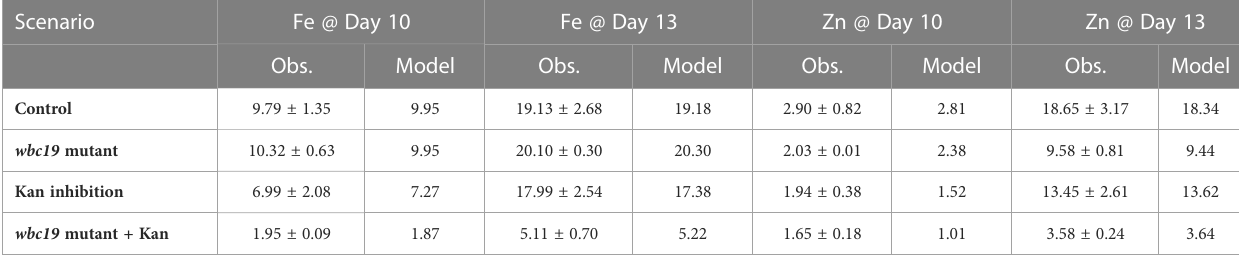
TABLE 2 Observed metal values (± SD) and values produced by the model, in units of m g of metal taken up by plants grown in one plate. Scenario